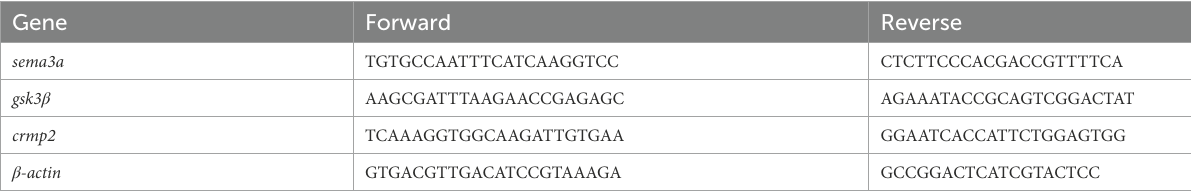
TABLE 2 The sequences of the primers used in this